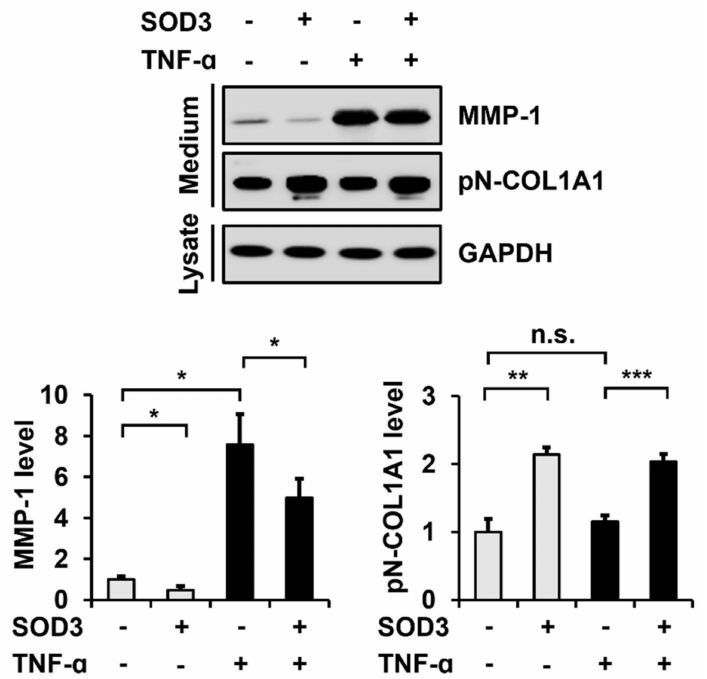
Figure 3. Effect of SOD3 on the secretion of matrix metalloproteinase (MMP)-1 and type I collagen in fibroblasts. Human foreskin fibroblasts were incubated in a serum-free medium in the presence of TNF- α (1 ng/mL) and/or SOD3 (3 µ g/mL) for 24 h. The secreted levels of MMP-1 and type I collagen in the conditioned media were assessed via western blot analysis using antibodies against MMP-1 and pN-COL1A1, respectively. GAPDH levels in cell lysates were analyzed as a loading control. Graphs show the levels of MMP-1 and type I collagen relative to the levels in non-treated cells, which were quantified using the ImageJ software. Each value represents the mean ± standard deviation of three independent experiments. * p < 0.05, ** p < 0.01, and *** p < 0.001 vs. control. n.s.: not